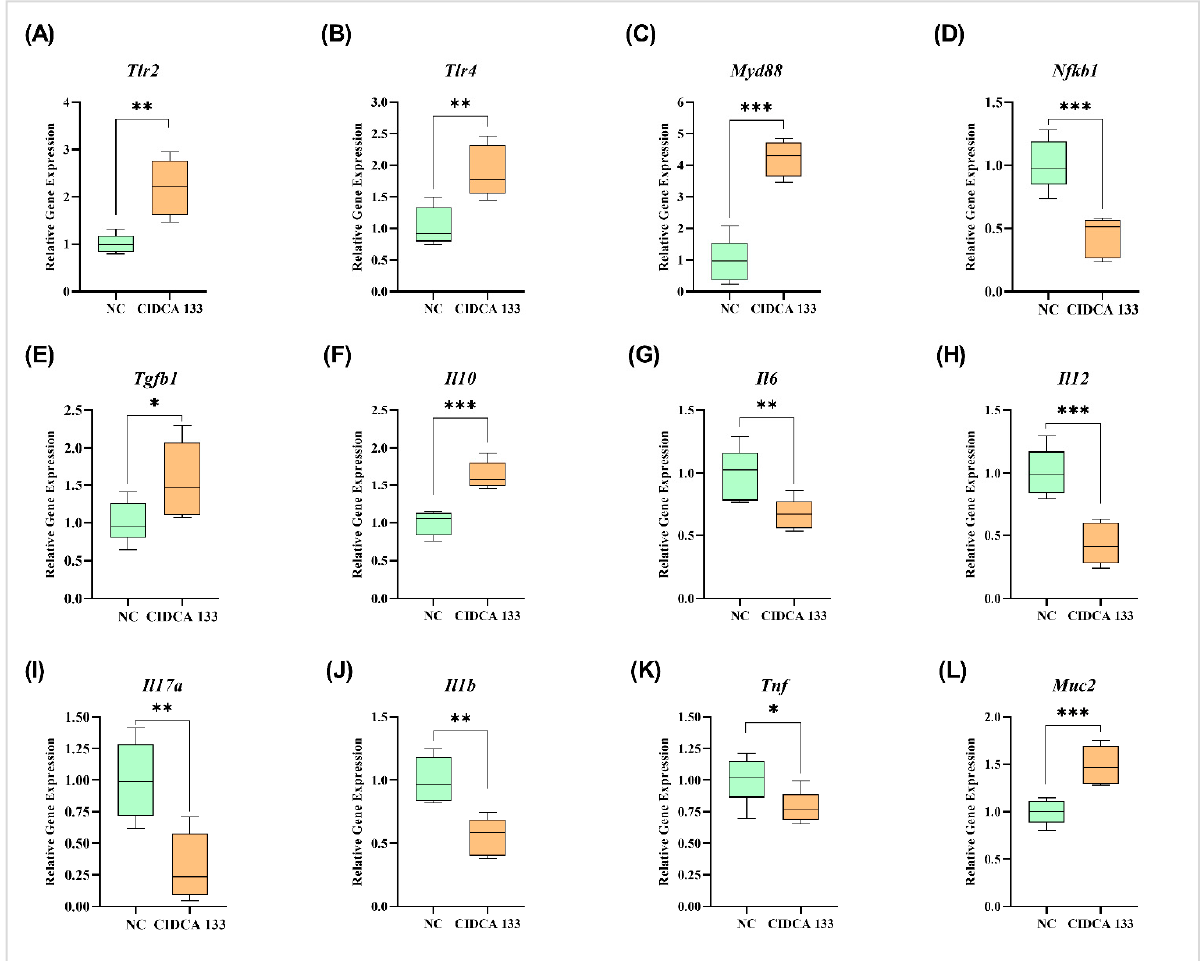
Figure 8. Relative gene expression of ( A – L ) Tlr2 , Tlr4 , Myd88 , Nfkb1 , Tgfb1 , Il10 , Il6 , Il12 , Il17a , Il1b , Tnf , and Muc2 in the ileum section of animals that received oral administration of L. delbrueckii CIDCA 133 for 13 consecutive days. Asterisk indicates statistical difference by Student’s t -test: * p < 0.05, ** p < 0.01, *** p <